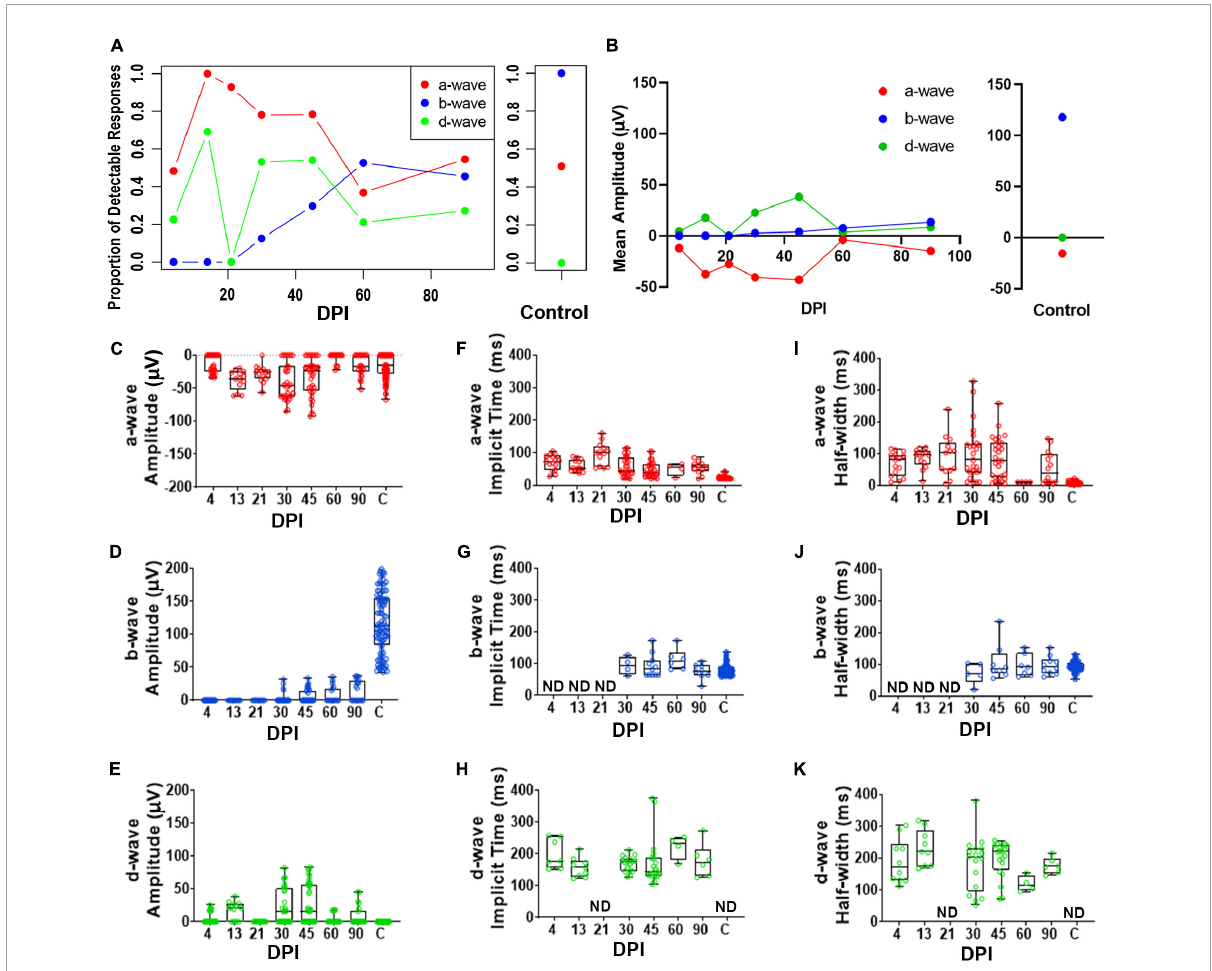
FIGURE3 Quantitative analyses of identified a-, b-, and d-waves over a regeneration time-course following an extensive lesion. (A) Proportion of detectable responses ( > 15 µ V deflections) recorded for apparent a-waves (red filled circles; defined as negative deflections during 0-200 ms of light stimulus), b-waves (blue filled circles; positive deflections during 0-200 ms stimulus), and d-waves (green filled circles; positive deflections after end of stimulus, 200-500 ms), over regeneration time-course for extensive lesion, and for contralateral, unlesioned control eyes. (B) Average peak amplitudes of a-, b- and d-waves over regeneration time-course, and for contralateral, unlesioned control eyes. (C–E) Peak amplitudes of a-waves (C) , b-waves (D) , and d-waves (E) . (F–H) Implicit times of a-waves (F) , b-waves (G) , and d-waves (H) . I-K. Half-widths of a-waves (I) , b-waves (J) , and d-waves (K) . Each symbol represents a value for an individual eye, the horizontal band represents the median, the top and bottom of each box (where present) indicate the 75th and 25th percentiles, and the whiskers represent the maximum and minimum. DPI, days post-injury; ND, not